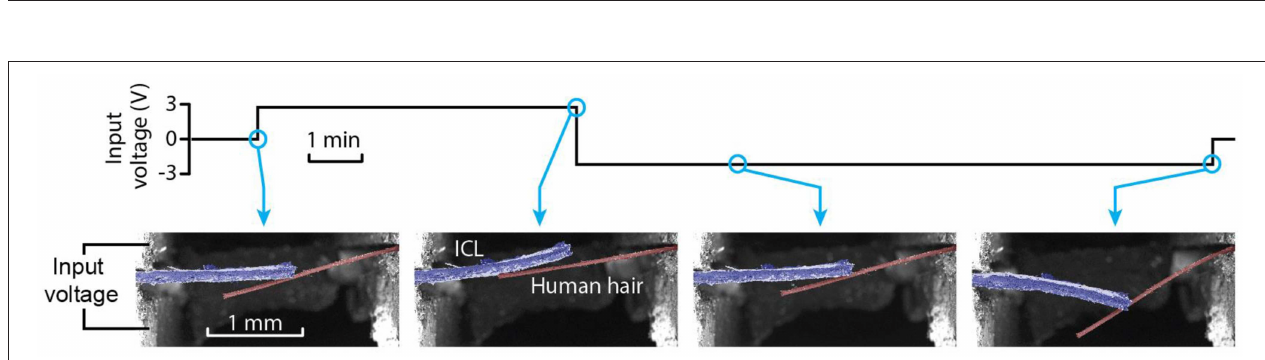
FIGURE 11 | Image sequence of an ICL actuator (false-colored in blue) probing human hair (false-colored in brown) in a vacuum.